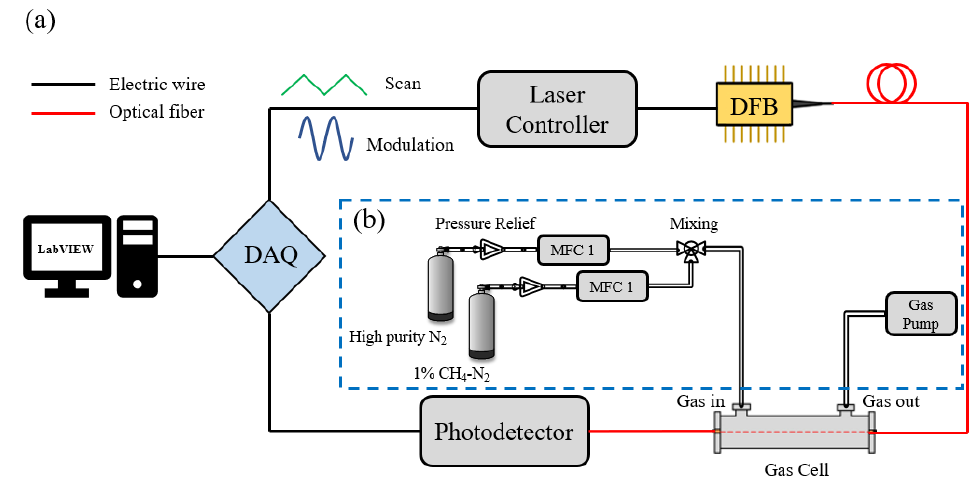
Figure 5. ( a ) Diagram of the experiment scheme; ( b ) Diagram of gas mixing system.